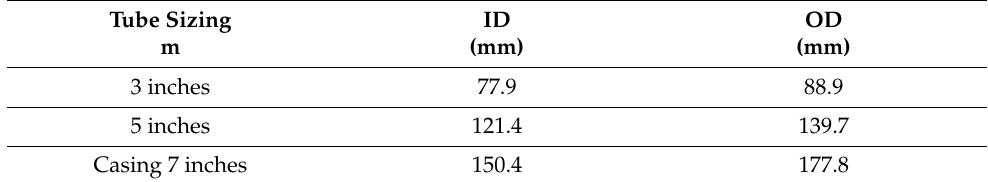
Figure 6. Coaxial WBHE geometry: considered configuration. Table 5. WBHE tube sizing—ID: internal diameter, OD: external diameter.